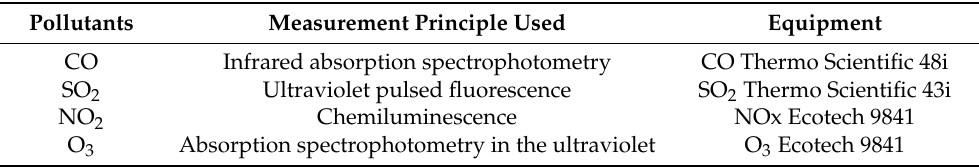
Figure A1. Fuel consumption from March to June 2018 and 2020. GNG sales data was only available at the national level. Table A3. Equipment used by BAQMD to monitor air quality in Bogota city [54]. Note that only the equipment that measures the parameters (pollutants) used in this comparison is shown.